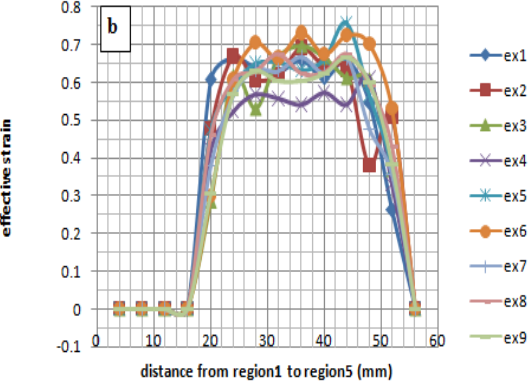
Fig. 13. Strain distribution over the formed sheet for nine experiments, a) 55 ◦ , b) 45 ◦ .